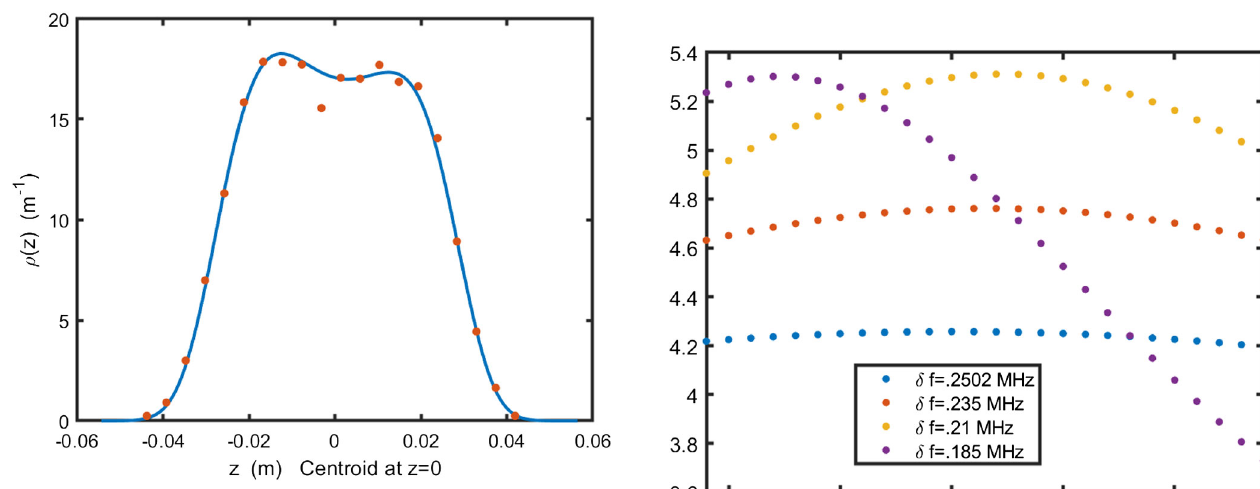
FIG. 18. Centroids of a train with distributed gaps, by macro- particle simulation (red dots) and Haïssinski solution (blue dots).